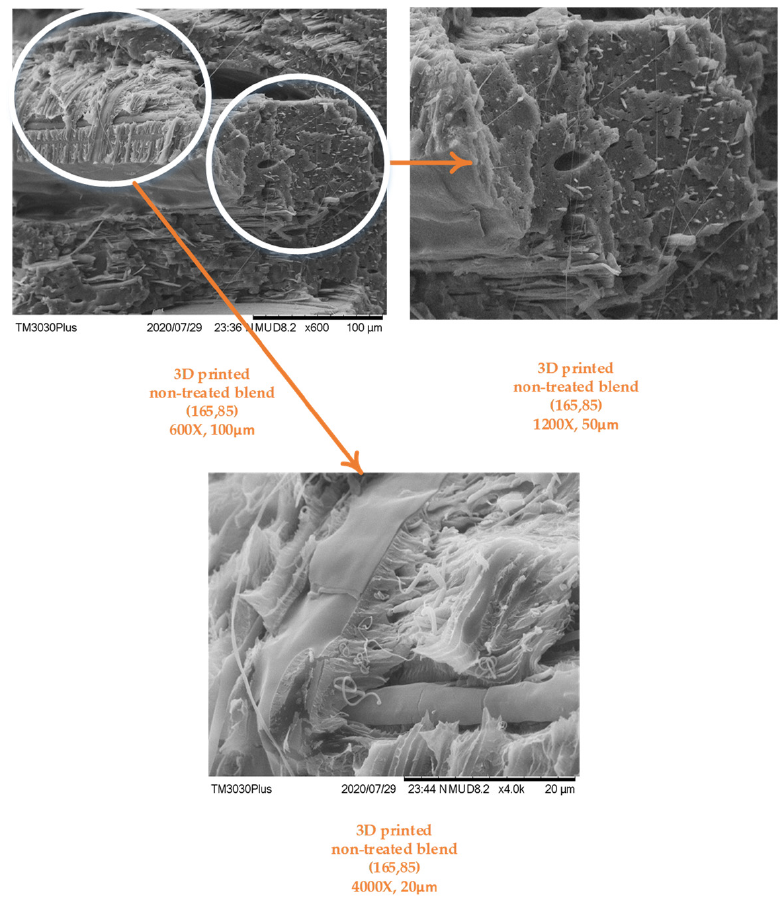
Figure 5. SEM analysis for melt blending in 3D-printed samples.